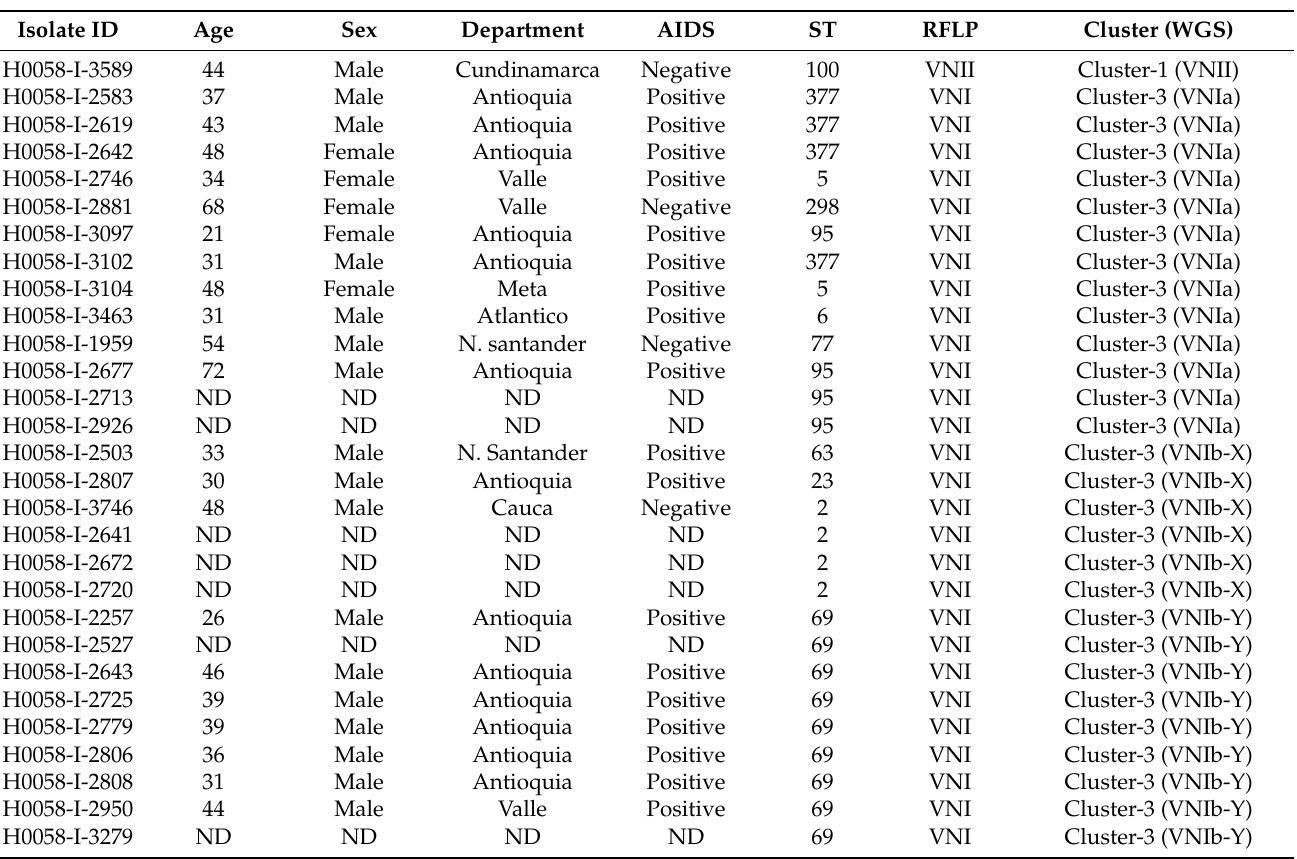
Table 1. Clinical and demographic variables and MLST and WGS results of 29 clinical isolates of C. neoformans